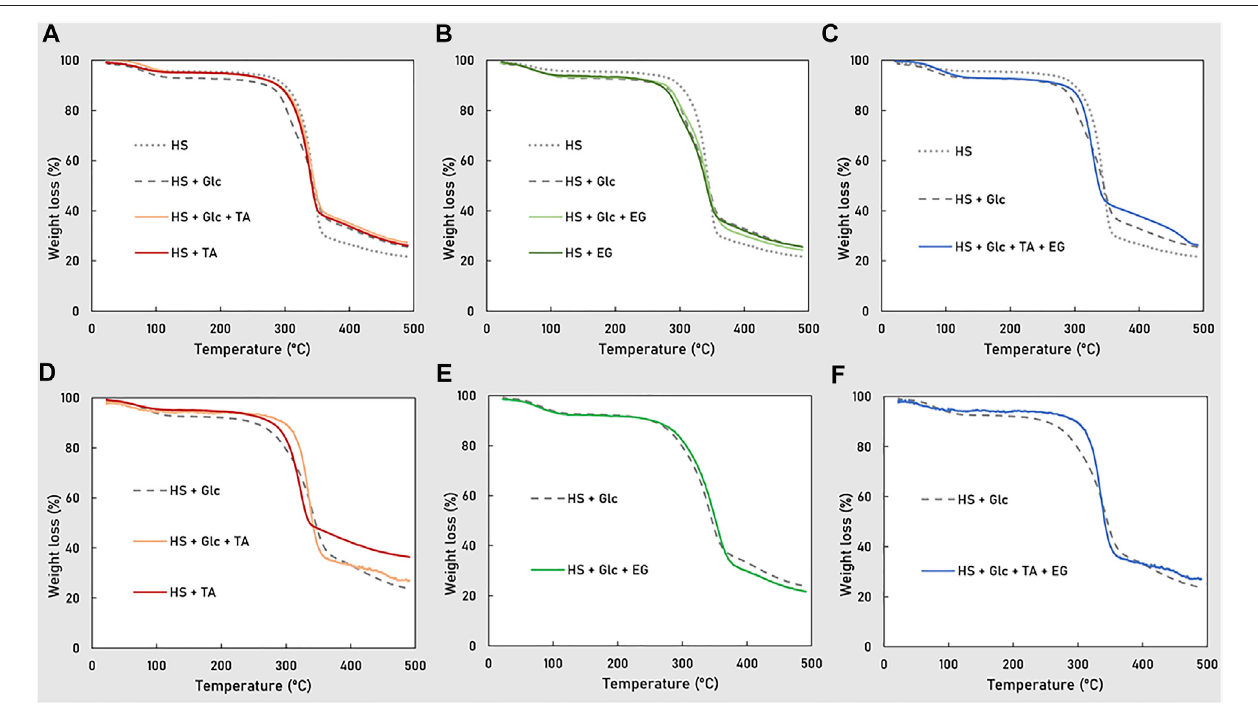
FIGURE 6 | TGA thermograms of BC produced by K. xylinus DSM 2004 (A – C) and DSM 46604 (D – F) , in the different tested media.